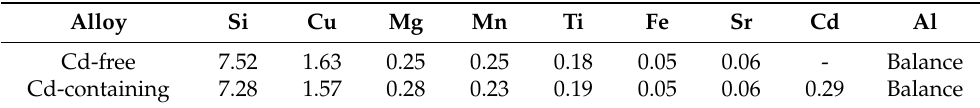
Table 1. Composition of different alloys